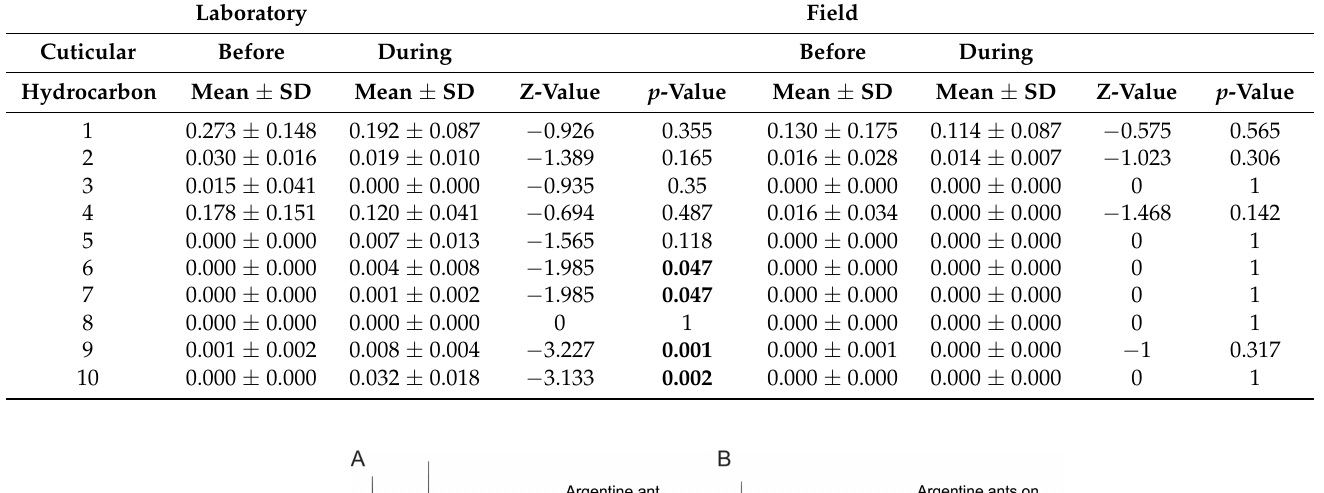
Table 4. Mean ± SD relative proportion of A. domesticus cuticular hydrocarbons peak areas in L. humile profiles before and during the dietary treatment. Z scores and p values are from Mann-Whitney U-tests. Bold indicates p < 0.05.